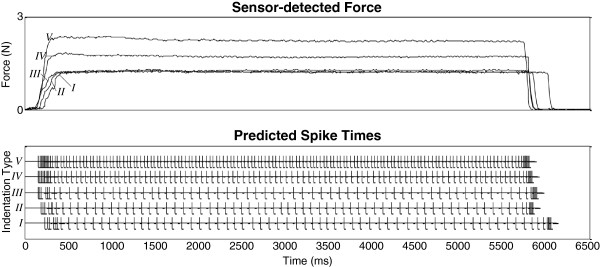
Data transformations using final parameter values. Using model parameter values obtained from final fitting iteration of second parameter fitting session, sensor-detected force is transformed to predicted spike times.